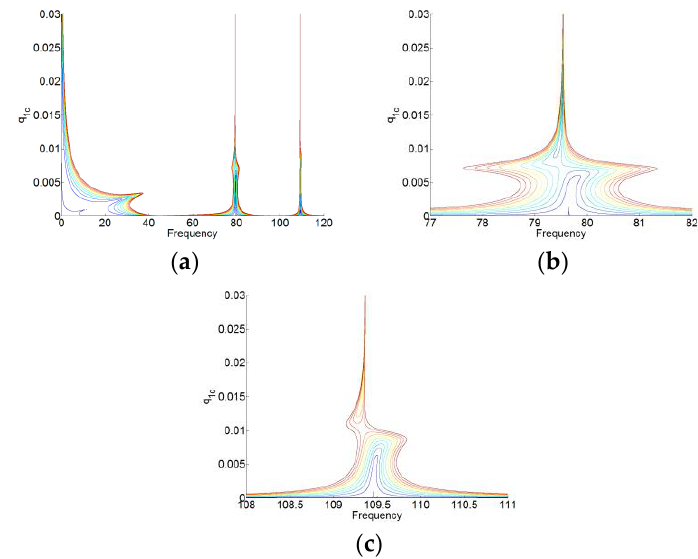
Figure 13. ( a ) Responses of q ( t ) for F 1 = [ 0.01 : 2 : 20.01 ] . ( b , c ) are the zooms of ( a ) around two resonant frequencies of the cavity.